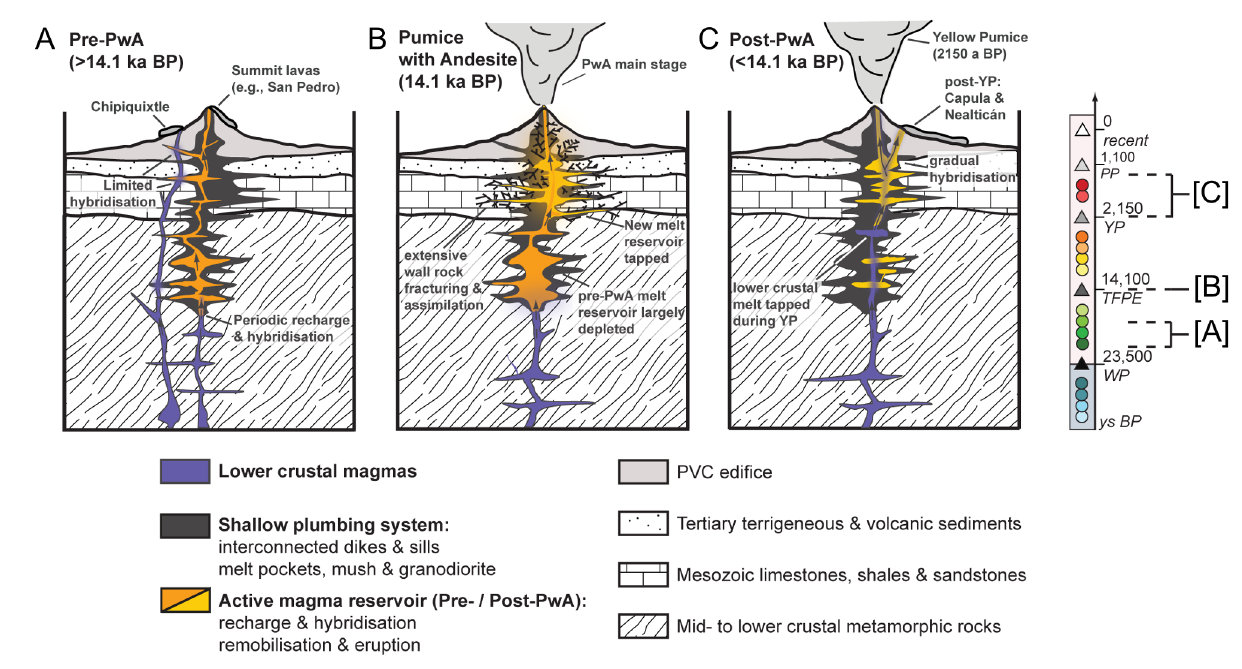
Figure 12: Schematic model of the evolution of the plumbing system of Popocatépetl volcano. [A] Pre-Pumice with Andesite (PwA, 14.1 ka BP). Periodic recharge of the main shallow magmatic body with lower crustal melts remobilises crystal mush and produces hybrid magmas erupting as summit lavas (e.g. San Pedro). In contrast, lower crustal melts largely circumventing the shallow magmatic body reach the surface after limited shallow hybridisation and thus preserve distinct compositions (e.g. Chipiquixtle). [B] The Pumice with Andesite erup- tion. The magma reservoir active previous to the PwA eruption is largely depleted during the initial stage of the PwA. A new shallow melt reservoir is tapped, associated with major wall rock fracturing, producing the explosive climax of the PwA main stage. [C] Post-PwA configuration, focussing on the Yellow Pumice Plinian Eruption (YP, 2150 a BP) and subsequent e ff usive eruptions. Lower crustal recharge triggers YP eruption, and lower crustal magmas are erupted in the late stage of the YP and during the subsequent Capula e ff usive flank eruption. Lavas of the Nealticán flank eruption record the waning influence of the lower crustal melt, sampling gradual hybridisation with shallow magma, which results in the bu ff ered compositions of the main PVC range.